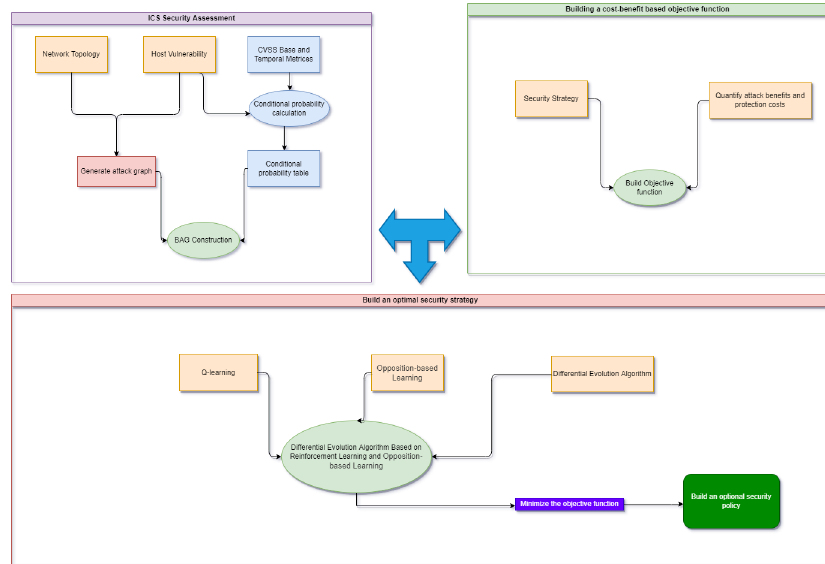
Figure 1. Optimal strategy selection framework for industrial